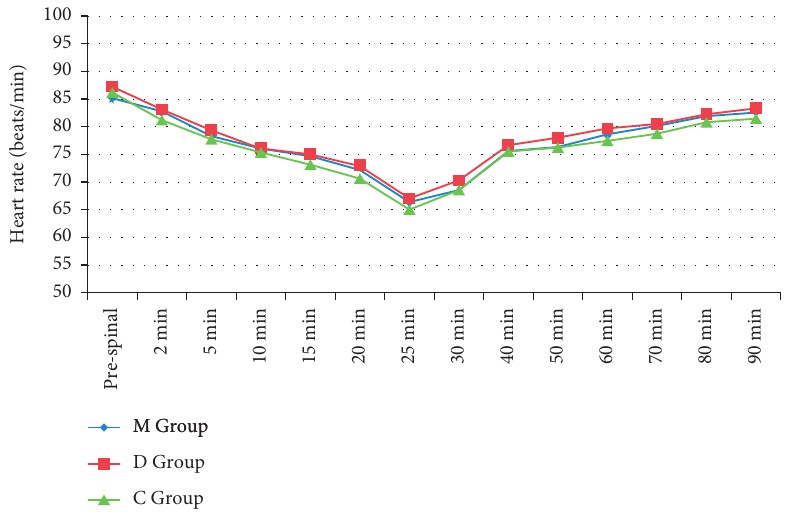
Figure 2: Heart rate (beats/min) changes over 90 minutes among the studied